Question: Author a descriptive caption for the visualization shown.
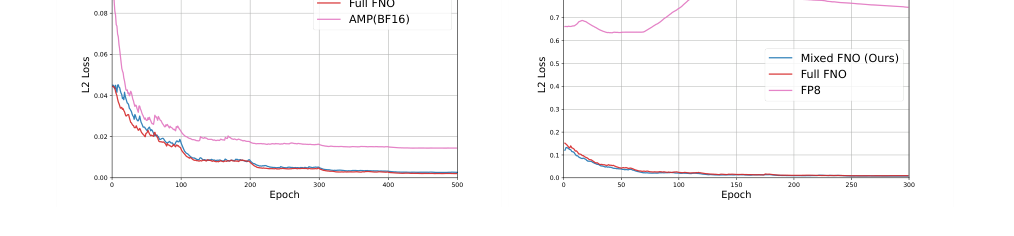
Answer: BF16 has significantly higher error compared to the other two approaches, possibly due to reduced bits for precision compared to FP16. FP8 training diverges due to the absence of precision bits in FP16.